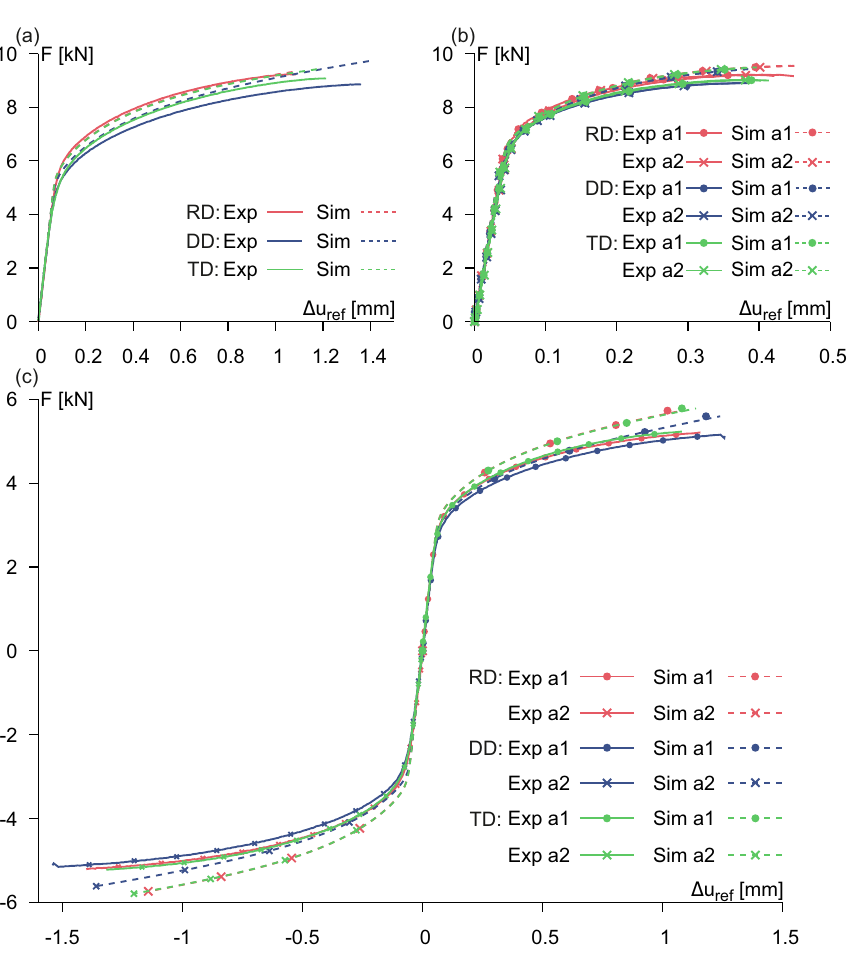
Figure 8. Load-displacement curves for the load ratios ( a ) F 1 / F 2 = 1/0, ( b ) F 1 / F 2 = 1/+1 and ( c ) F 1 / F 2 = 1/ −